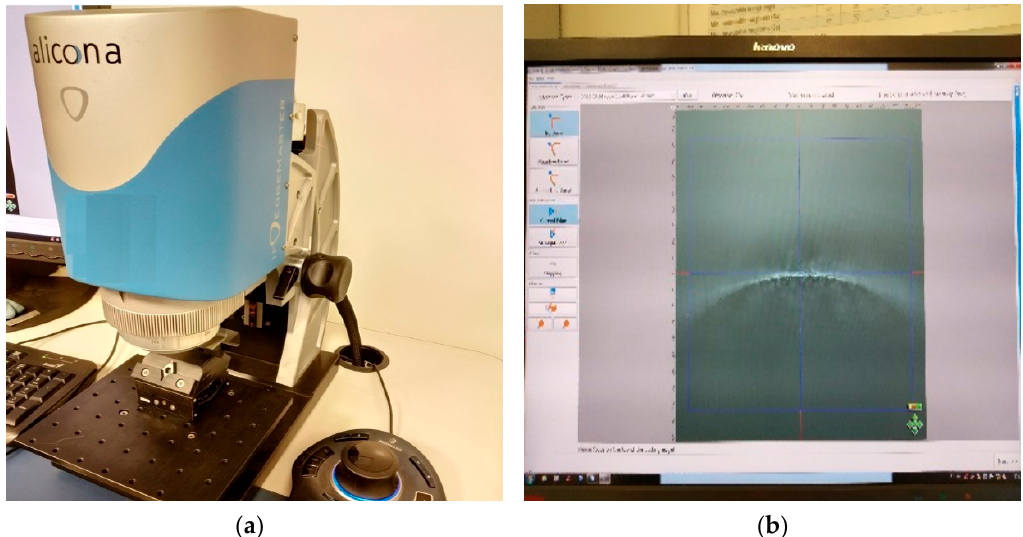
Figure 8. ( a ) Measuring the radius of curvature of the cutting edge on Alicona 3D optical microscope; ( b ) Cutting edge display measuring with Alicona 3D software.